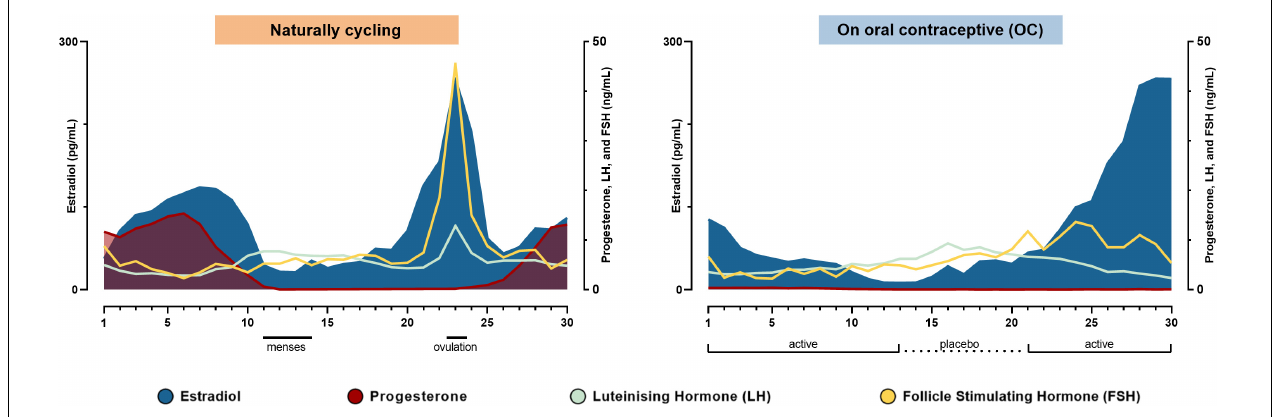
FIGURE 1 | Hormonal timelines in each of the two conditions. The subject’s hormone levels during the natural cycle and while taking the oral contraceptive in the order of experiment days. Modified from Taylor et al. (2020).